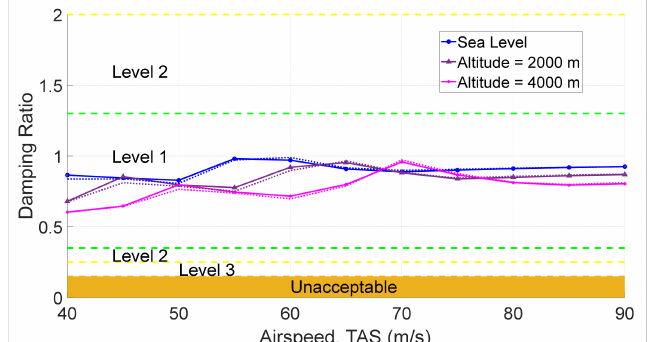
Figure 15. Damping ratio versus various airspeeds for Short Period oscillations; (solid lines account for the optimization using mass minimization scenario and dotted-lines are for the drag optimization in trim flight).